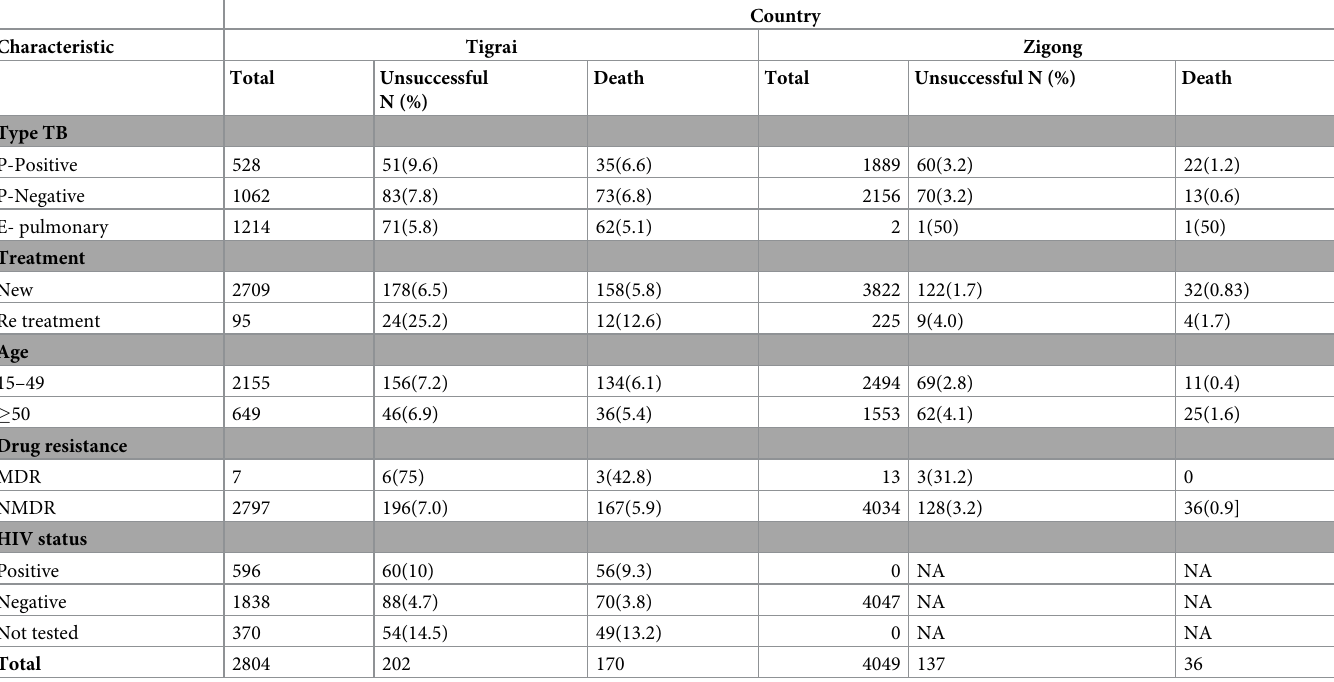
Table 2. Women clinical factors and level of unsuccessful treatment outcome in Tigray and Zigong from January 2007–December 2016[N = 2804 and N = 4047].